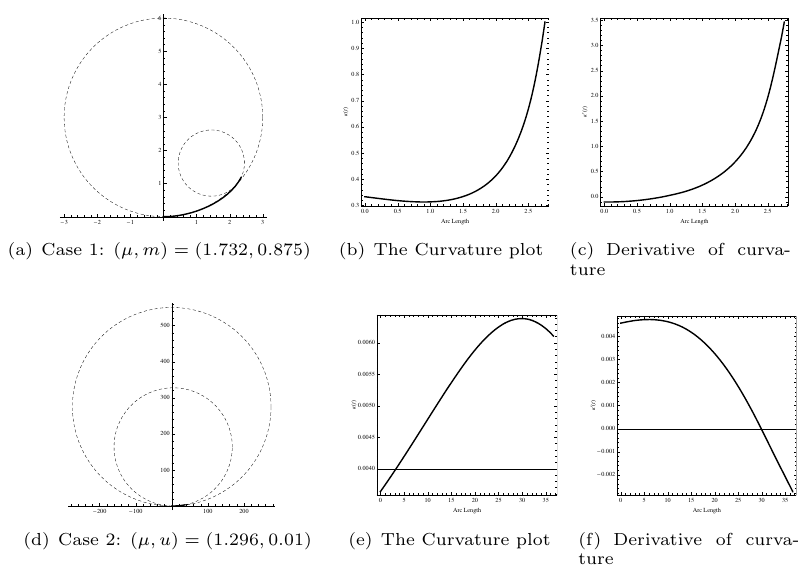
Figure 7. C-shaped transition curves (left) with single curvature extremum.